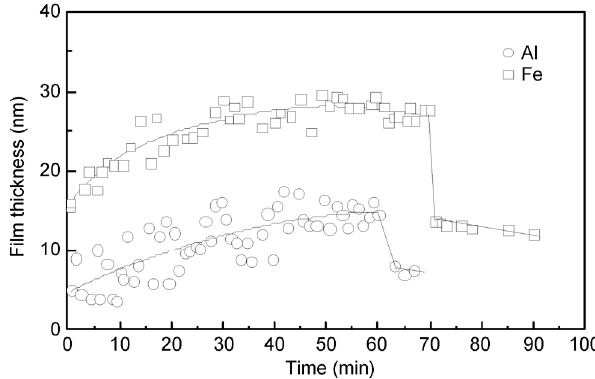
Fig. 18 Film thickness versus time of mineral oil on different substrates under a speed of 4.49 mm/s, a load of 7 N, measured by Luo et al. [4,